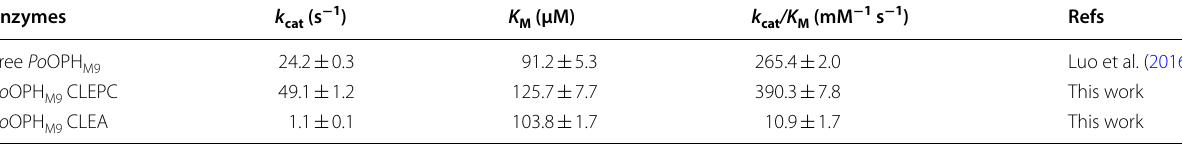
Table 1 Kinetic parameters of the free and immobilized enzymes toward malathion